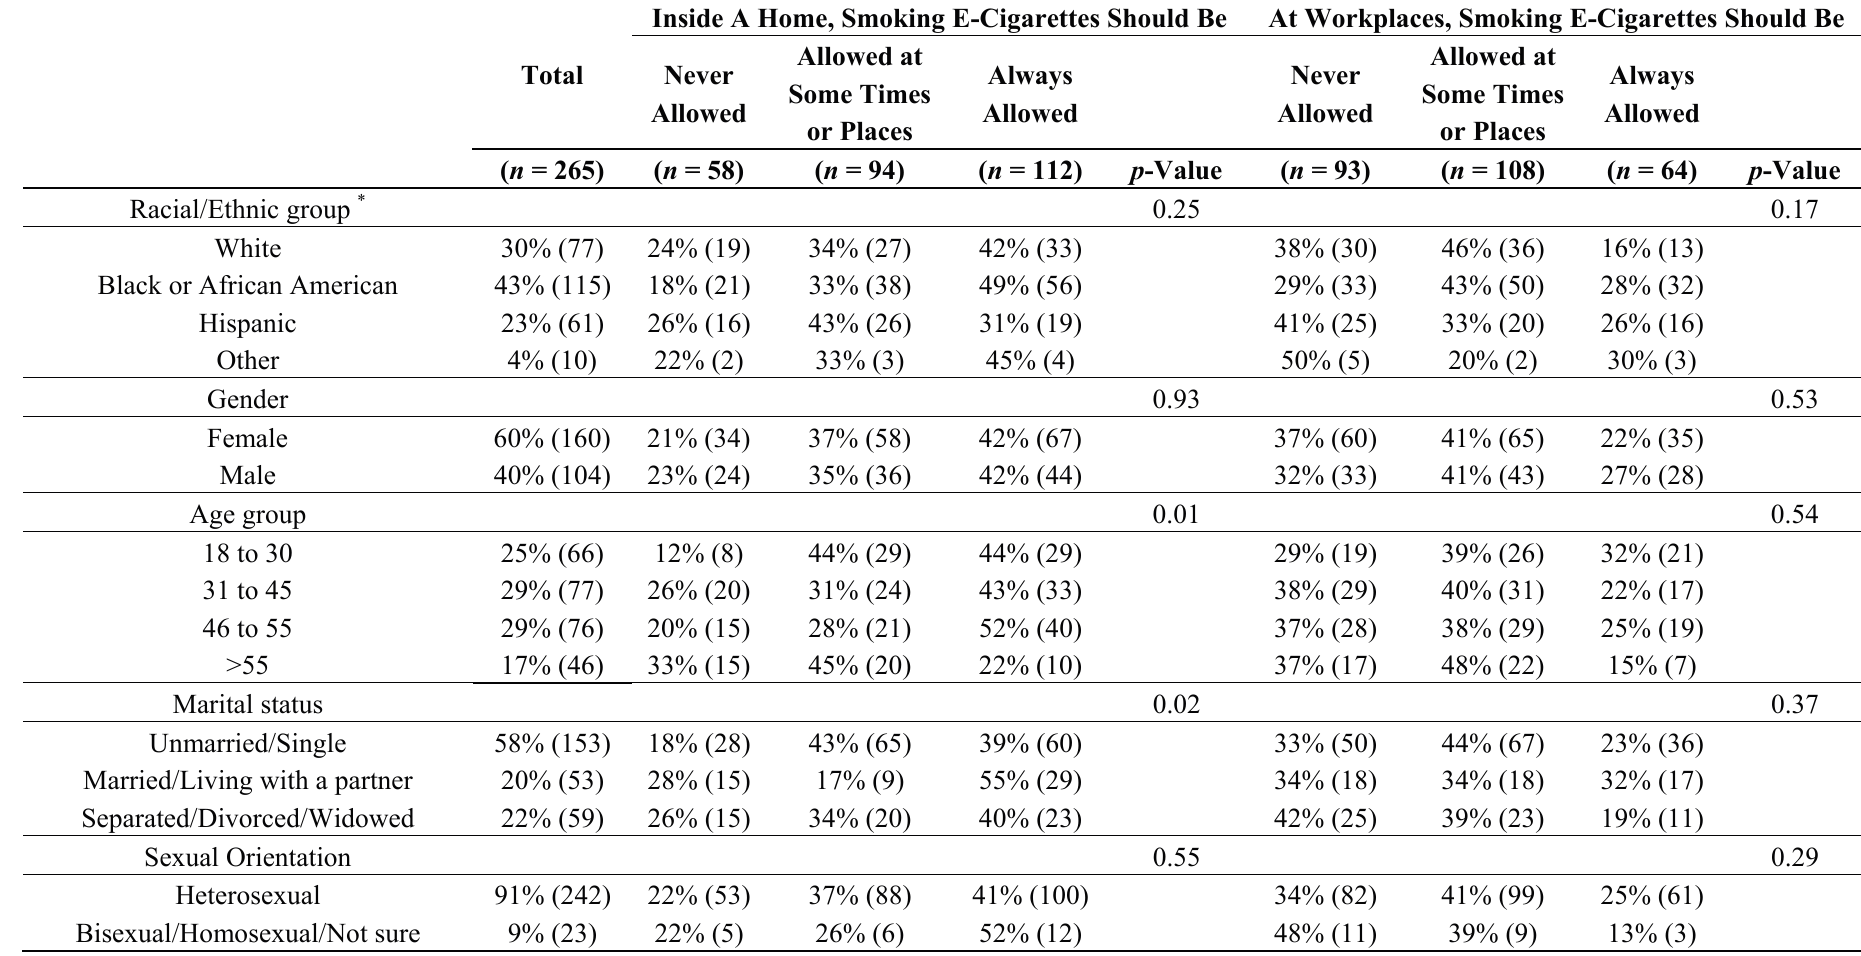
Table 1. Demographic characteristics and support for indoor home and workplace e-cigarette